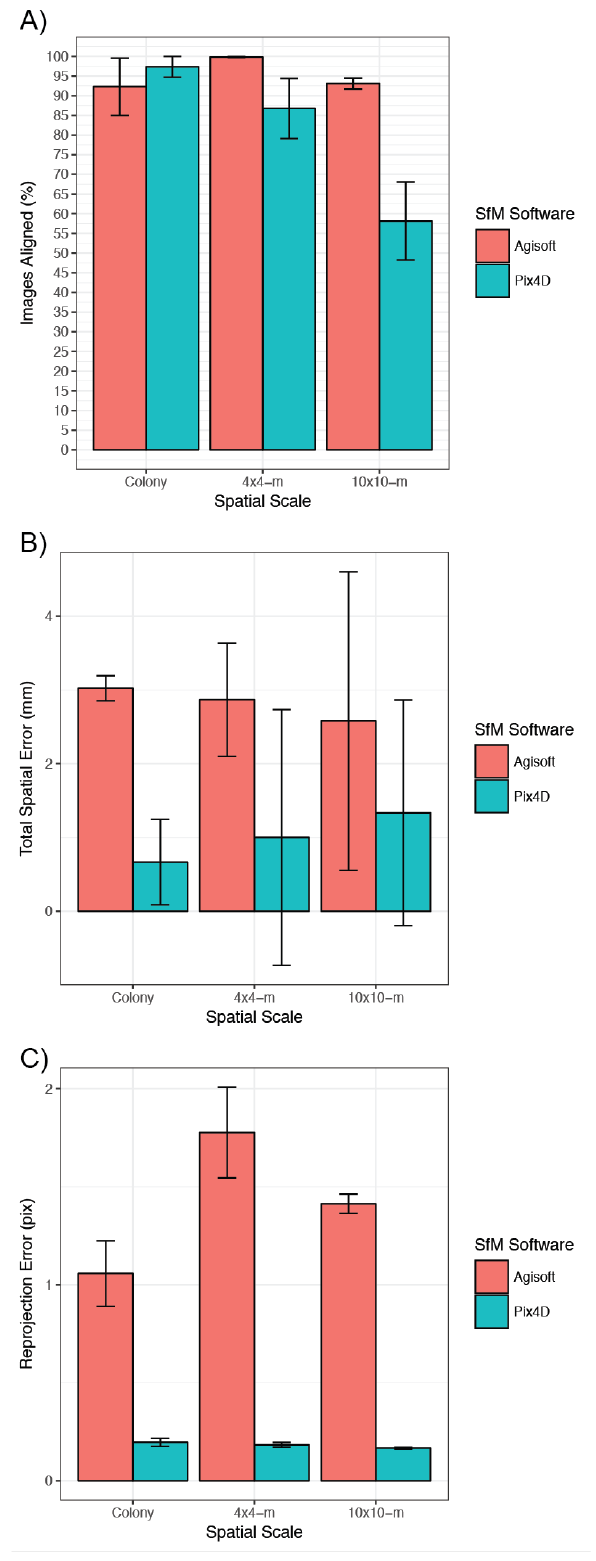
Figure 2. Statistical comparisons among mean values of 3D reconstruction metrics: a) image alignment, b) total spatial error (mm), and c) reprojection error (pix). Error bars represent standard error of mean values for each